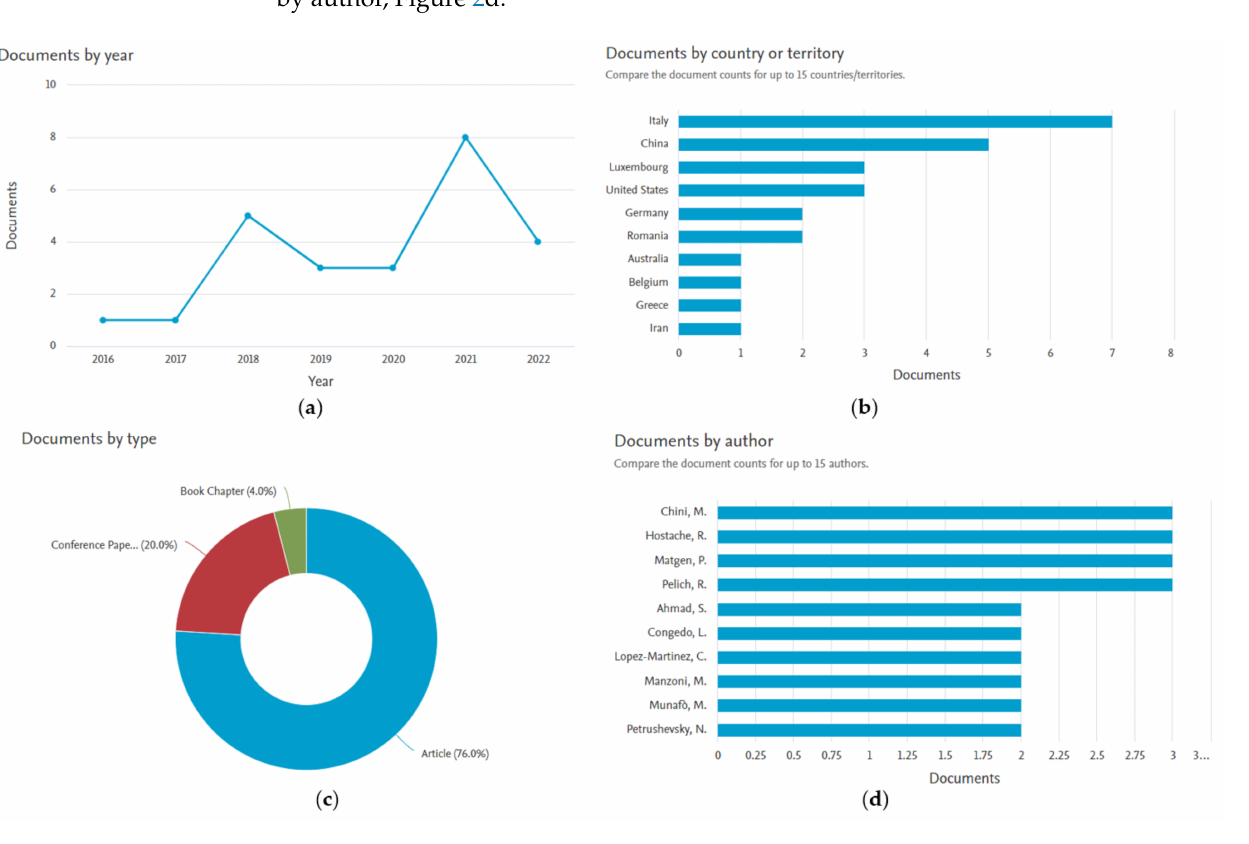
Figure 2. ( a ) Documents by year, ( b ) Documents by country, ( c ) Documents by type, ( d ) Documents by author (statistics extracted from Scopus